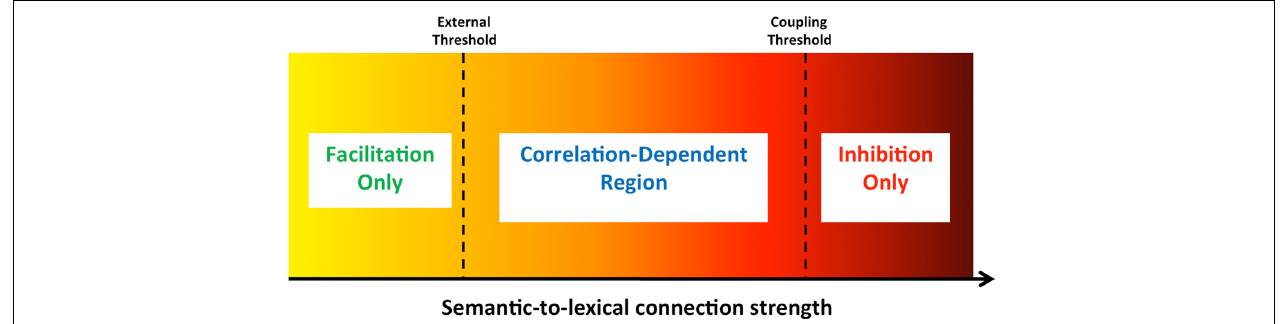
FIGURE 4 | General regions of facilitation and inhibition as a function of the semantic feedback strength. Regions are depicted under the assumption that the semantic network is converged to a pattern correlated (but not identical) to the incoming target. With a connection value below the